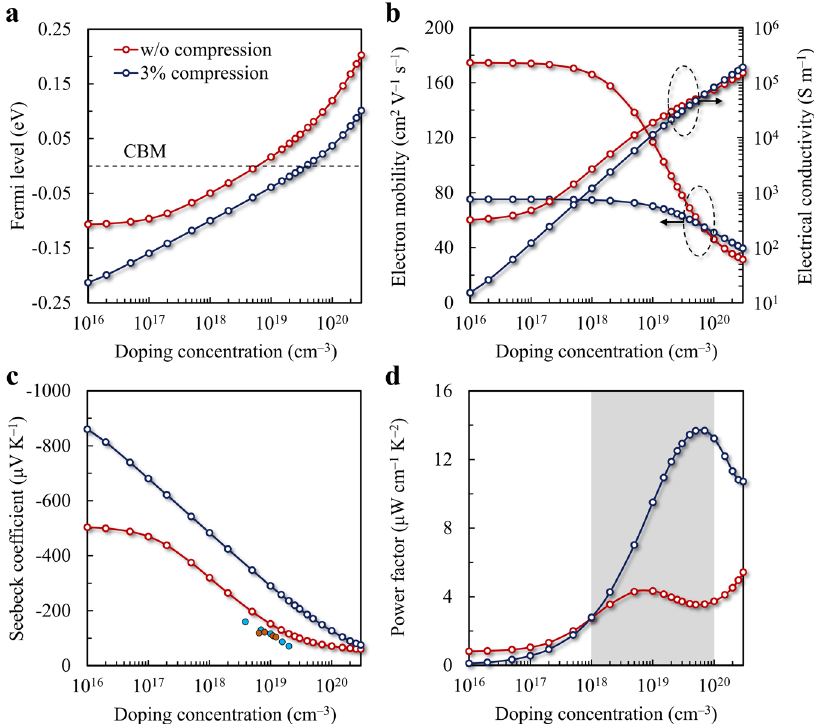
Fig. 5 Thermoelectric transport properties of n -type SnTe at 300 K with different doping concentrations. a The Fermi level, b electron mobility and electrical conductivity, c Seebeck coef fi cient, and d power factor of n -type SnTe for different doping concentrations at 300 K. The red and blue circles represent the crystal at 0% and 3% compression, respectively. The solid circles in c illustrate the experimental results 42